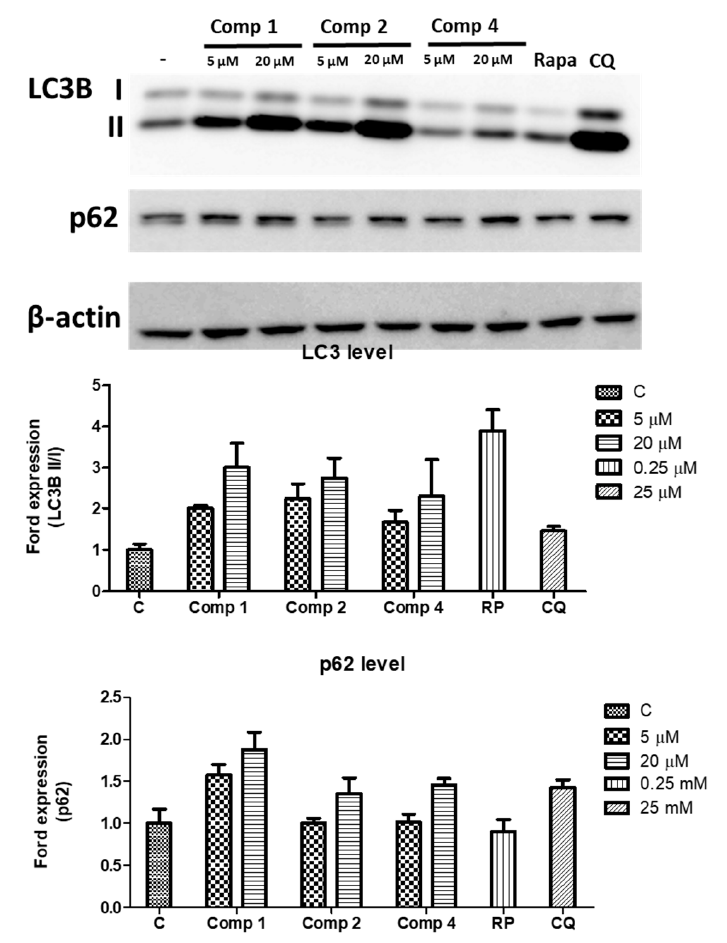
Figure 5. The autophagy-related protein expression level of compound-treated cells. LC3B was calcu- lated by the LC3B II/I ratio, and the ratio was normalized to the control group (nontreated group). The p62 protein level was detected, and the expression level was divided by the control group’s protein level for normalization. (Rapa: rapamycin treatment group; CQ: chloroquine treatment group).